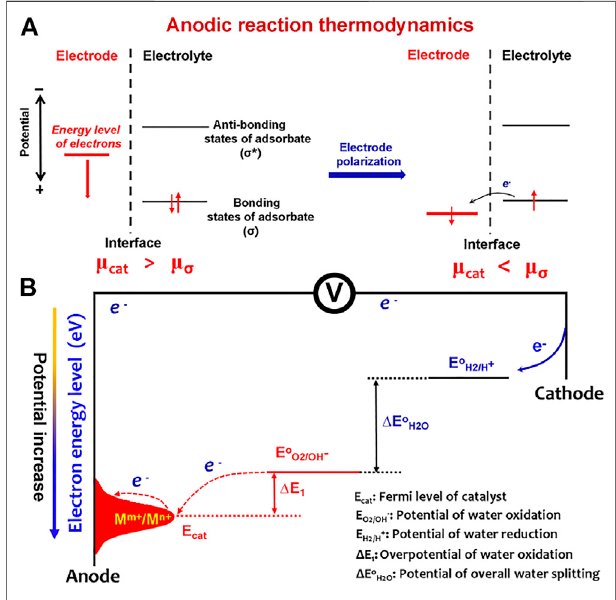
FIGURE 1 | (A) Anodic reaction thermodynamics. After electrode – electrolyte contact, the initial equilibrium state between the electrode catalyst and OER adsorbates was established by orbital hybridization interactions. When applying external potentials, the Fermi level ( μ cat ) of catalyst is polarized to an energy level lower than the bonding states ( μ σ ) of adsorbates; thus, the OER process occurs. (B) Barriers of the OER to occur on an electrode include the barriers from electrode catalyst polarization by varying valency of ions (M m+ /M n+ ) and the barriers from water oxidation by high-valence ions (M n+